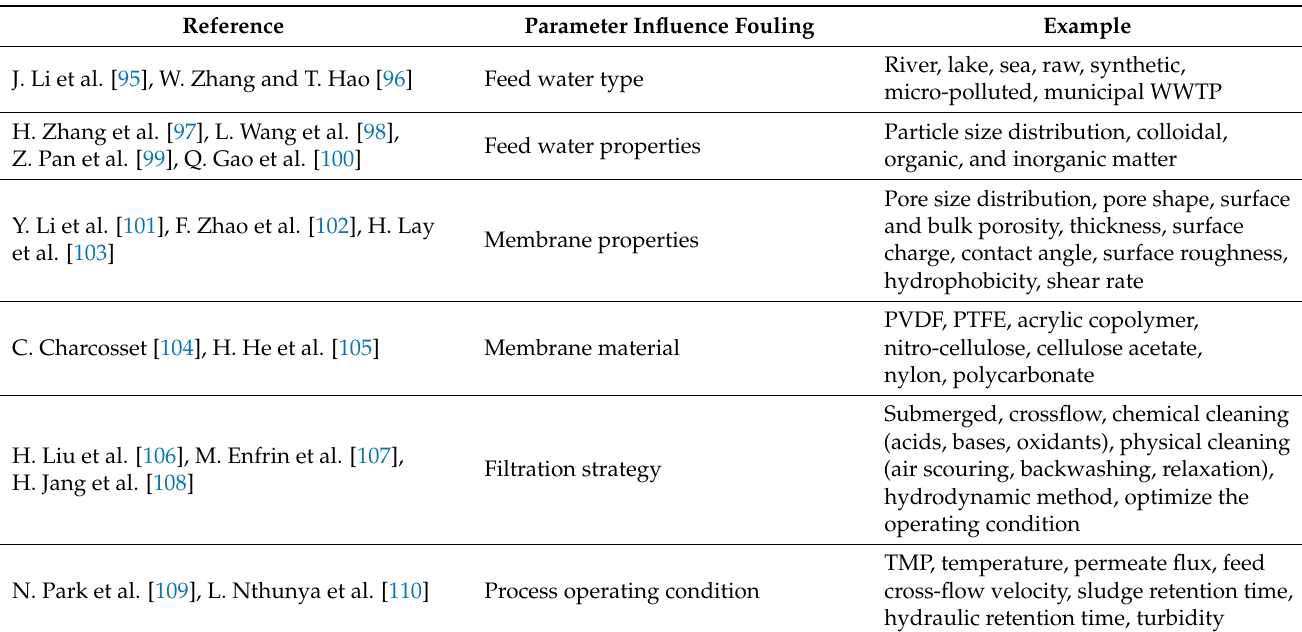
Table 3. Parameter that influences the fouling growth